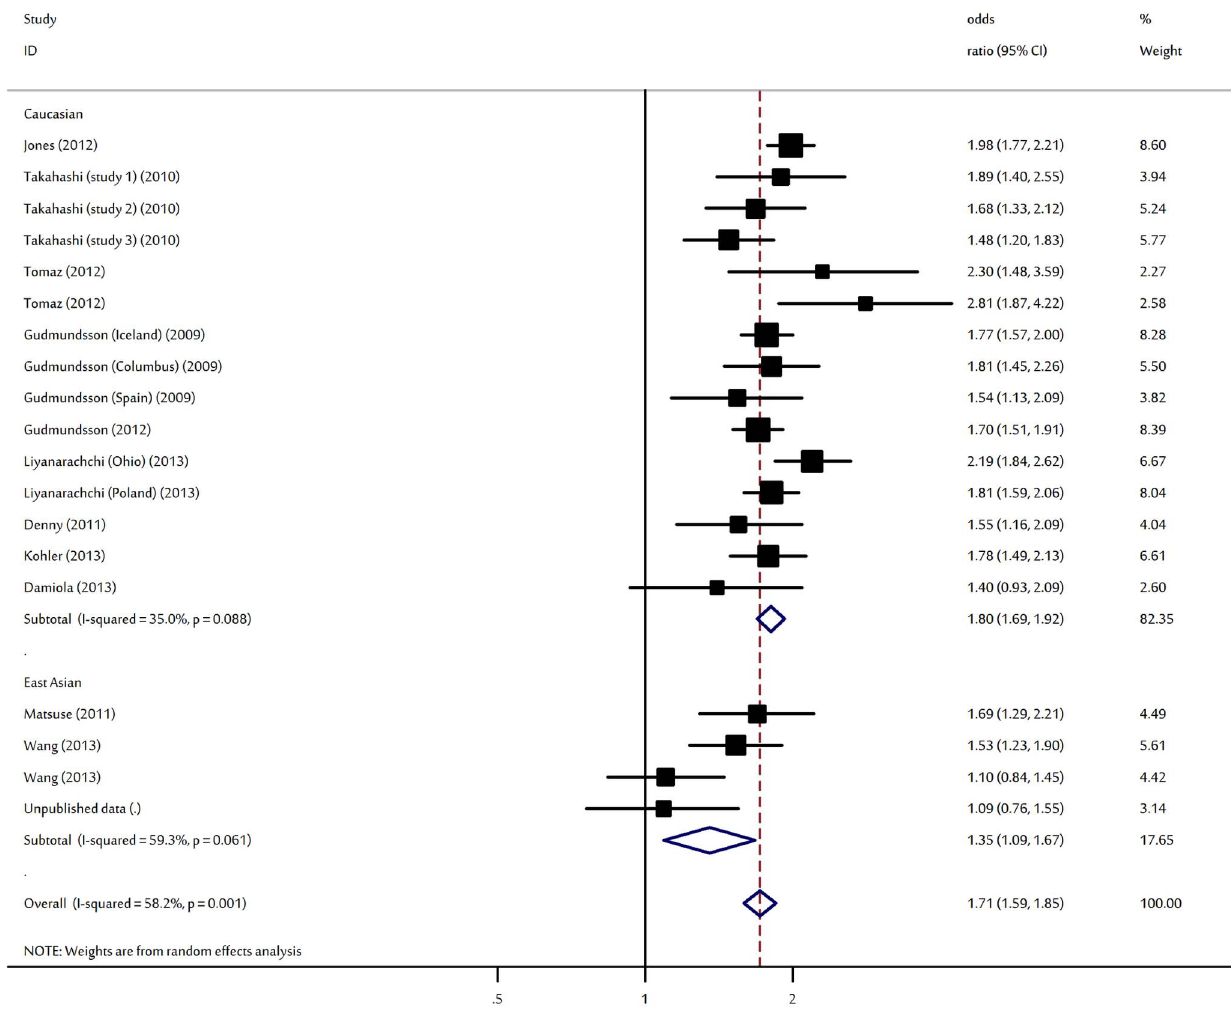
Figure 1. Forest plot for association of FOXE1 rs965513 polymorphism and thyroid cancer risk.